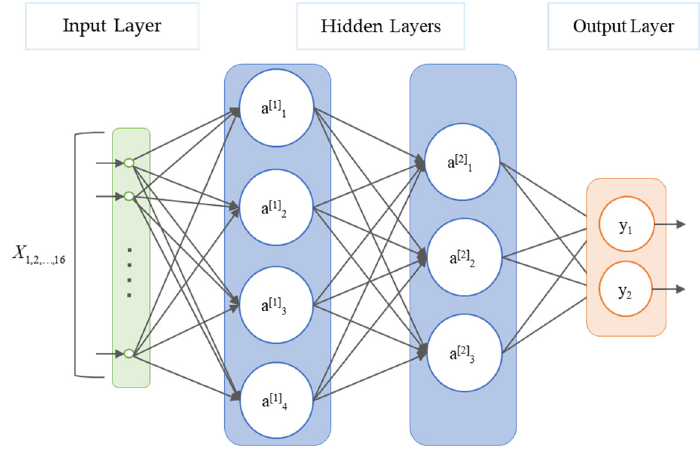
Figure 4. The architecture of the proposed MLP for clear sky detection.